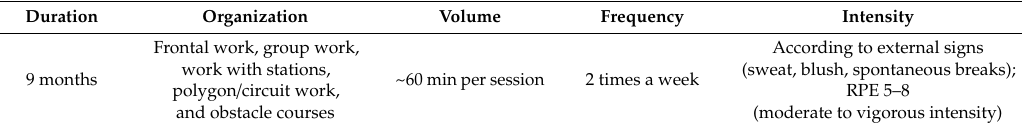
Table 1. The structured multisport exercise